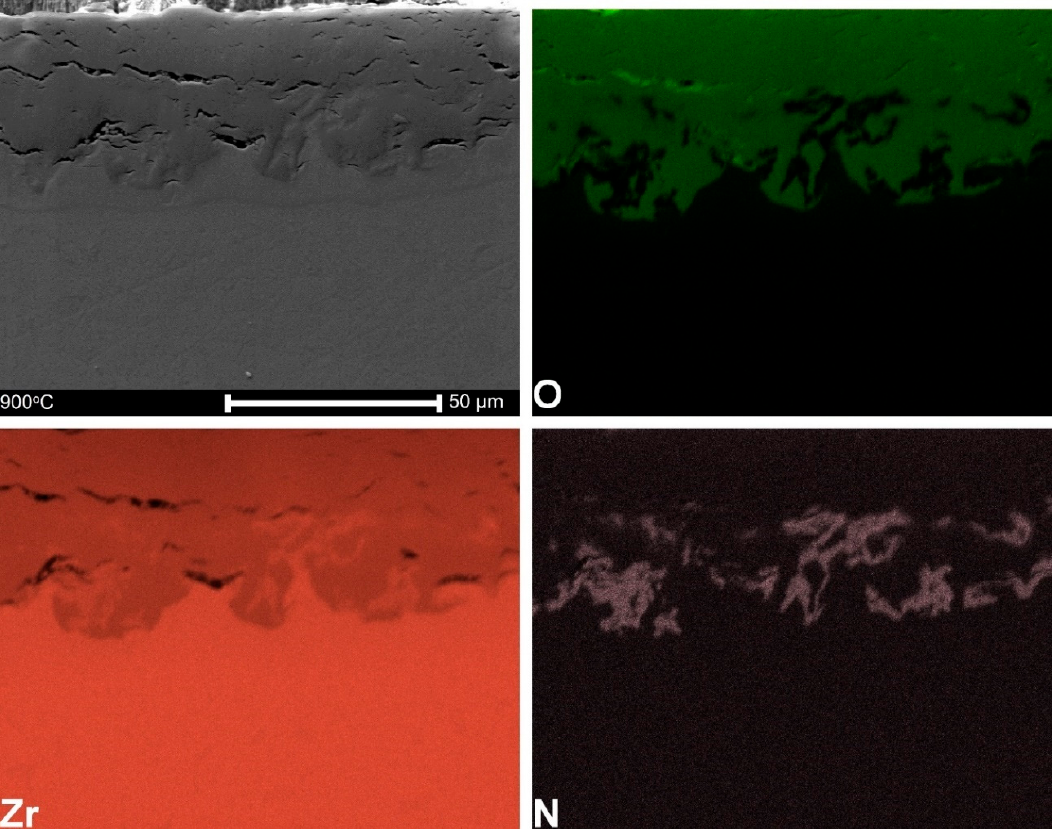
Figure 3. The mapping of primary elements within the oxide layer formed after oxidation at 900 °C.